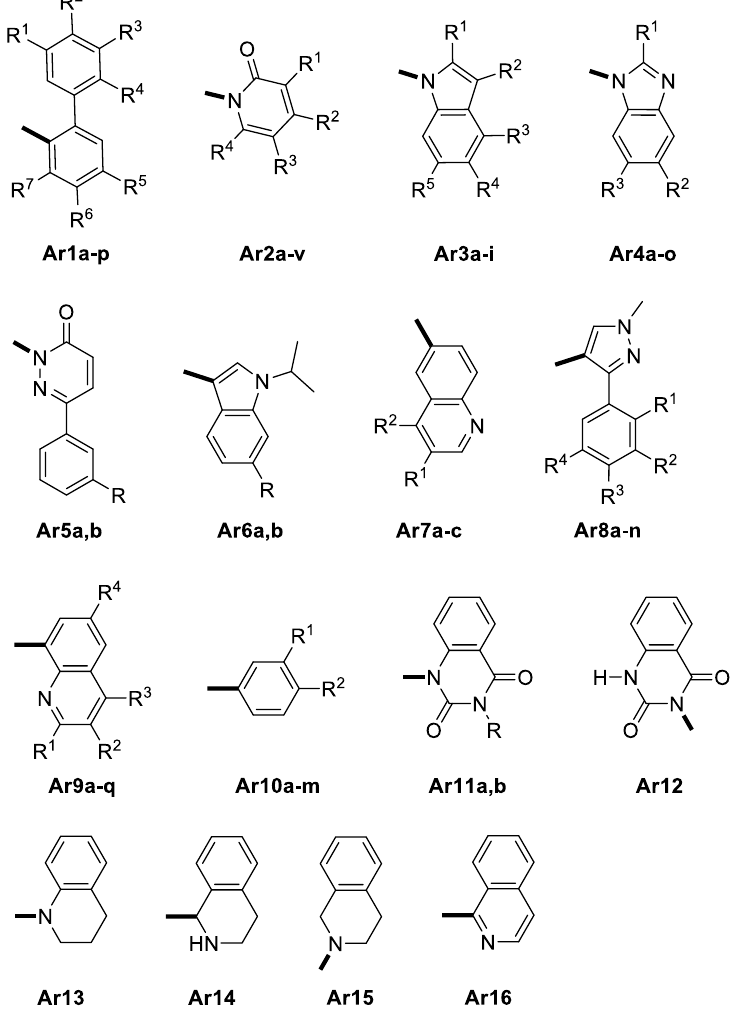
Figure 4. Structures of the aromatic fragments. The full fragment library is given in Table